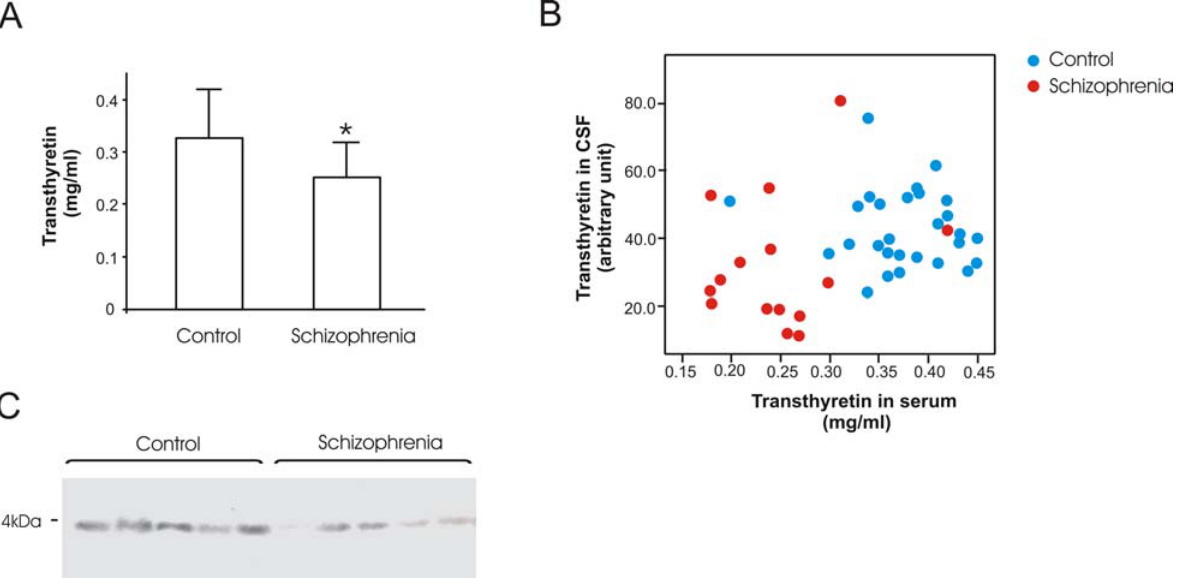
Figure 5. Transthyretin Levels in Sera of First-Onset, Drug-Naı¨ve Schizophrenia Patients and Prefrontal Cortex Post-Mortem Tissue from Schizophrenia Patients The serum samples from the same patients whose CSF protein profiles were measured in Figures 1 and 6 were included in this study. Figure 5A shows serum tranythyretin levels in patients with schizophrenia significantly decreased by ; 15% compared to control subjects. Data are shown in mean 6 standard deviation, and the asterisk denotes p ¼ 0.0007 ( t -test). Figure 5B indicates no correlation between serum transthyretin and CSF SELDI signals from one of the transthyretin isoforms ( m/z ¼ 13,741) in the second sample set (for demographics, see Table 2). Similar results were found when comparing with signals from other isoforms in CSF (unpublished data). Figure 5C shows an ; 40% decrease of transthyretin expression in prefrontal cortex of five patients with schizophrenia and in five control subjects. For demographic details, see Table 5.